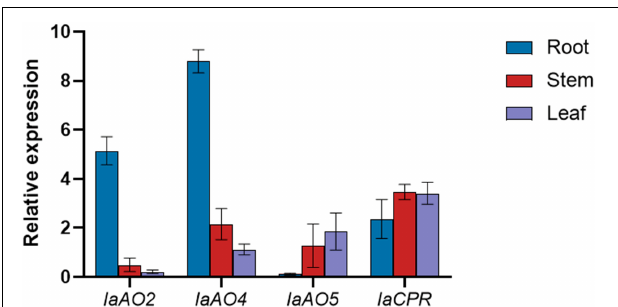
FIGURE 8 | qPCR analysis of CYPs and CPR in different parts of I. asprella plants. The relative fold expression of genes in different organs (root, stem, and leaf) is shown.